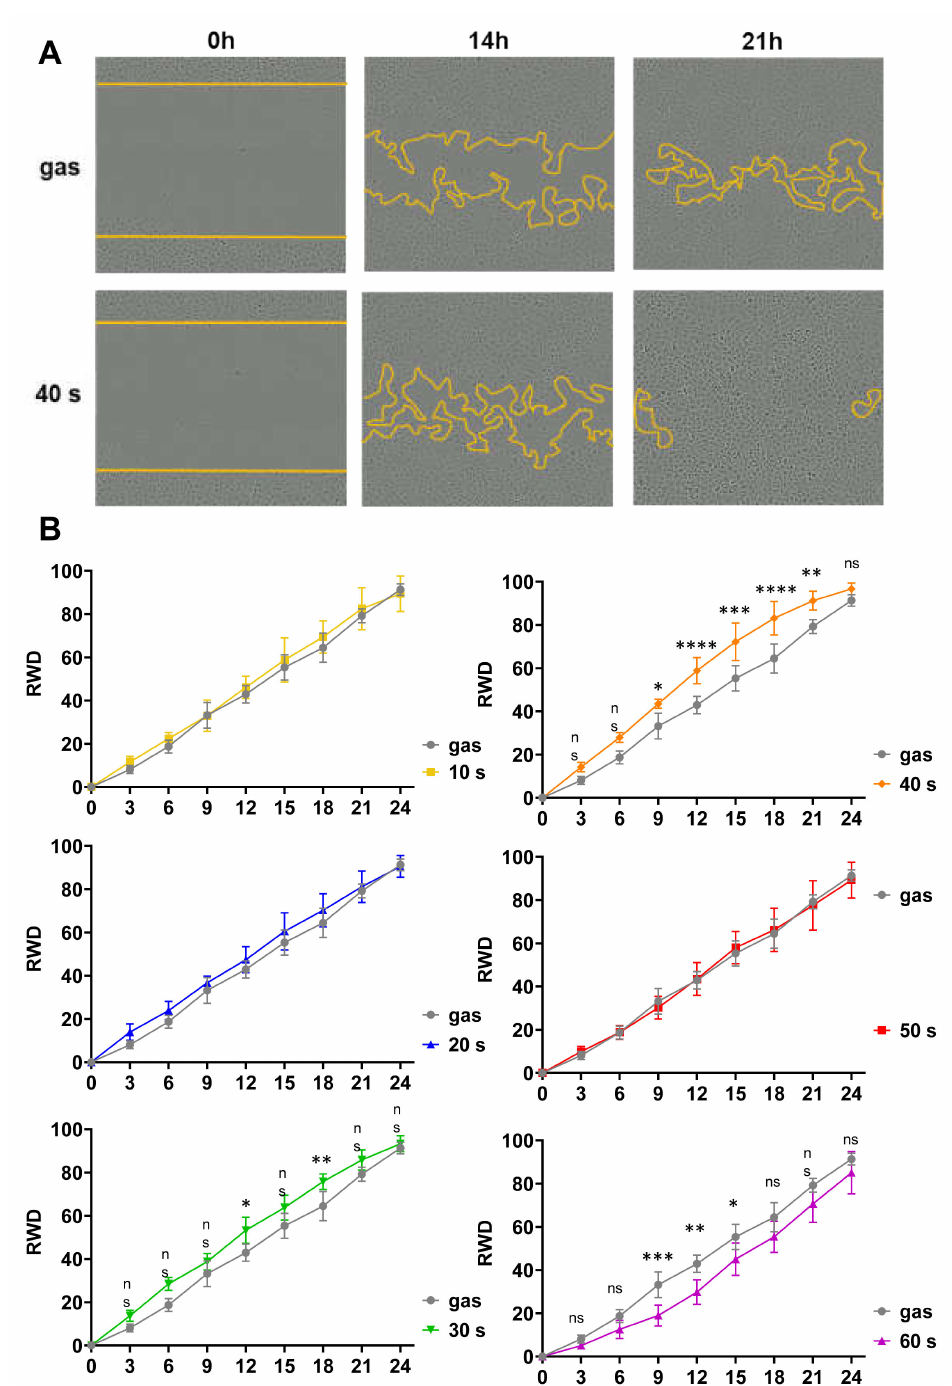
Figure 3. Short-time CAP treatments of N/TERT-1 increased cell migration. Standardized scratches were made on a completely confluent cell monolayer, cells were exposed to CAP for between 10 s and 60 s, and images of the wound area were taken at hourly intervals for 24 h to quantify cell migration. Treatments with gas alone for 60 s was used as control. ( A ). Representative images of those taken immediately after the scratches (0 h), and 14 h and 21 h later. Yellow lines indicate the edges of the wound. ( B ). Quantitative analyses of scratch fillings were performed, and the results are expressed as relative wound density (RWD). The results corresponded to the measurements in 6 separate wells; n = 6, error bars represent S.D.; *, p < 0.05; **, p < 0.005; ***, p < 0.001; ****, p < 0.0001; ns: not